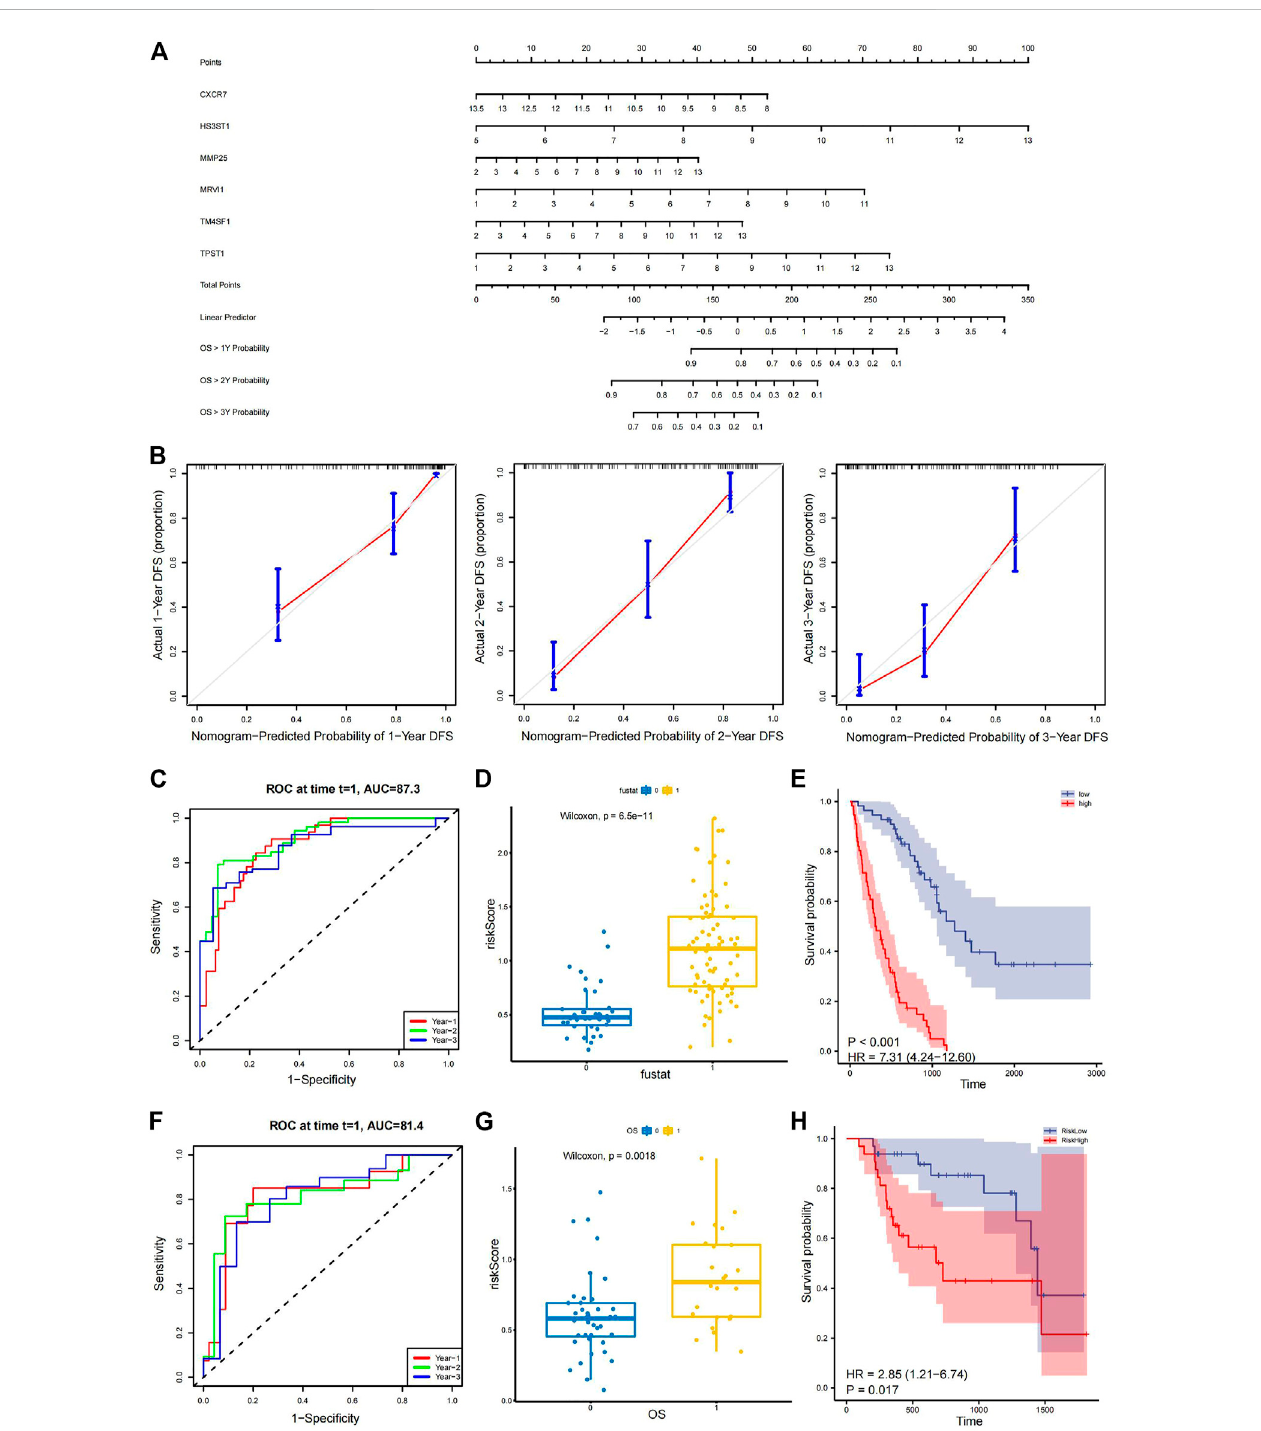
FIGURE 7 Evaluation and validation of prognostic models. (A) Nomogram of the model for 1-, 2-, and 3-year overall survival rates. (B) Calibration curves of the modelbasedon1-,2-,and3-yearoverallsurvivalrates. (C) Time-dependentROCcurvebasedonthemedianofriskscoreinthetrainingset.The1-yearAUCis .727, the 2-year AUC is .905, and the 3-year AUC is .868. (D) Box plots showing that the Wilcoxon P -test results ( P = 6e-11) are less than .05 between the different groups based on the median of risk score in the training set. (E) Kaplan – Meier survival curve showing a clear difference between groups based onthemedianofriskscoreinthetrainingset[HR=7.31,95%CI:(4.24,12.60), p < .001]. (F) Time-dependentROCcurvebasedonthevalidationset.The1-year AUC is .814, the 2-year AUC is .814, and the 3-year AUC is .808. (G) Box plots presenting a signi fi cant difference ( p = .0018) in the validation set. (H) Kaplan – Meier survival curve showing a clear difference in the validation set [HR = 2.85, 95% CI: (1.21, 6.74), p = .017]. ROC, receiver operating characteristic; AUC, area under the curve; HR, hazard ratio; CI, con fi dence